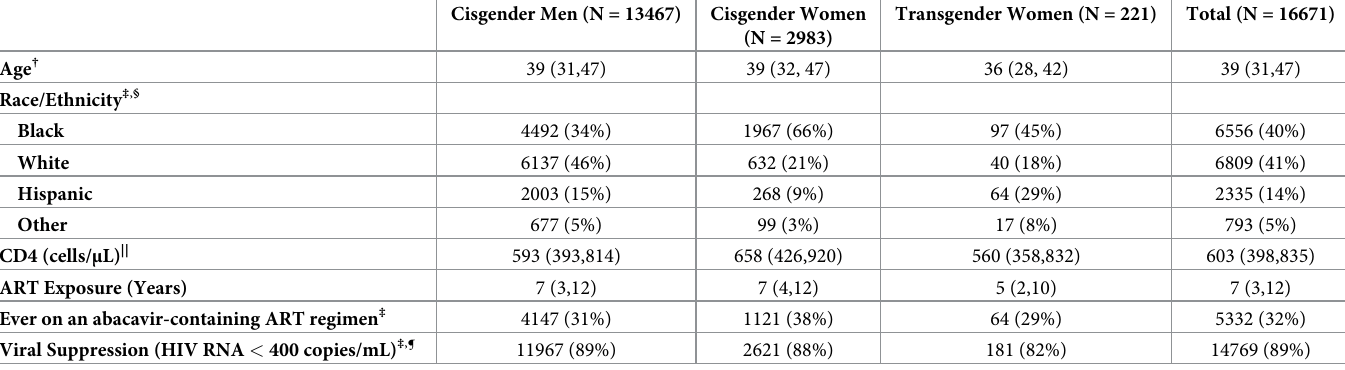
Table 1. Baseline demographic and HIV-related characteristics of 16,671 adults alive and in care at a CNICS site as of the site-specific administrative censoring date, October 2014-February 2018 �